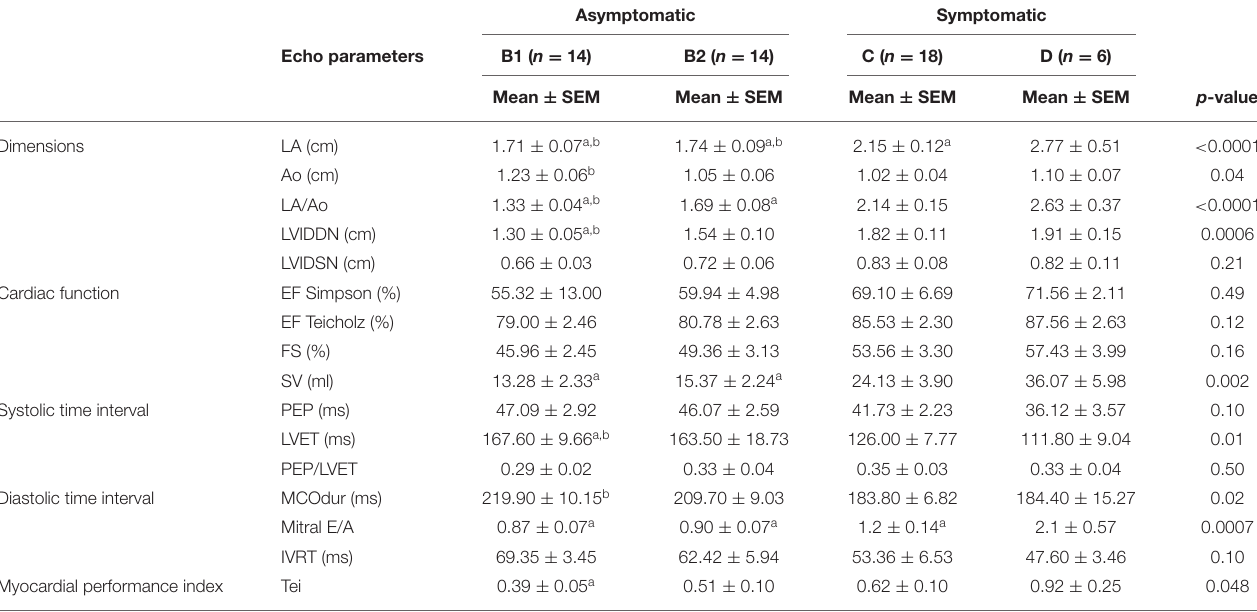
TABLE 2 | Echocardiographic parameters describing various stages of